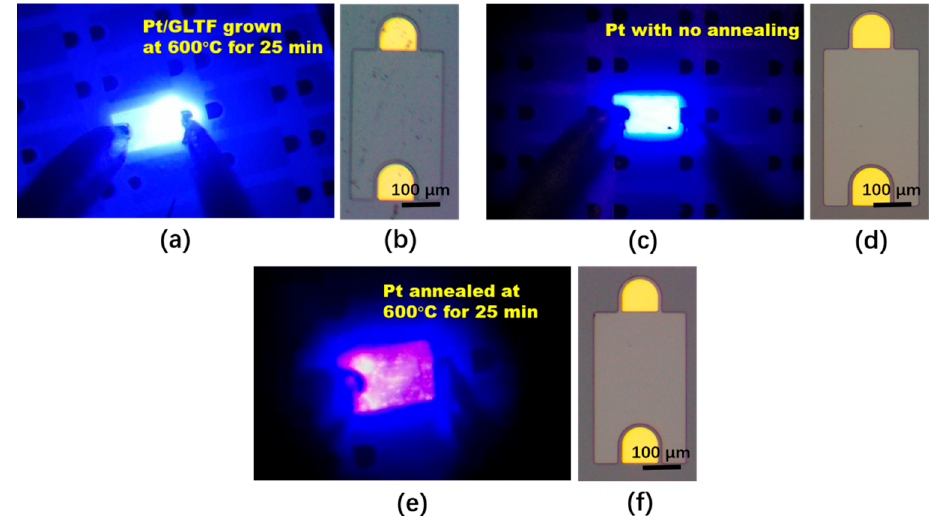
Figure 4. A current–voltage (I–V) curve comparison of the LED devices of GaN substrates without any treatment, with Pt film, with annealed Pt film, and with Pt-GLTF film. Figure 5 displays electroluminescent photos of samples 2–4 operating at 5 V, together with their corresponding optical micrographs for a single device. Figure 5a,b shows the platinum-GLTF LEDs (sample 4), Figure 5c,d shows the platinum film LEDs (sample 2), and Figure 5e,f shows the annealed platinum LEDs (sample 3). It can be seen that the Blu-ray luminescence is very uniform for the